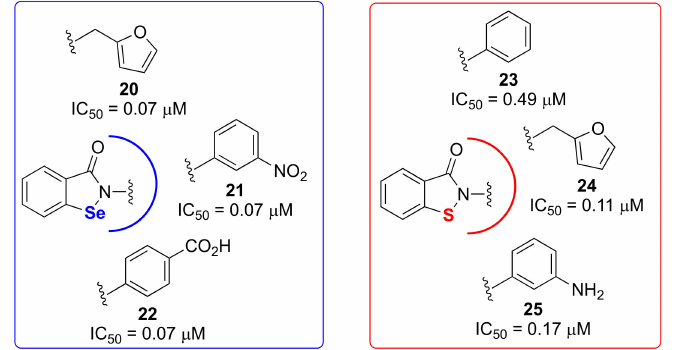
Figure 2. Ebselen and ebsulfur analogues endowed with anti-M pro